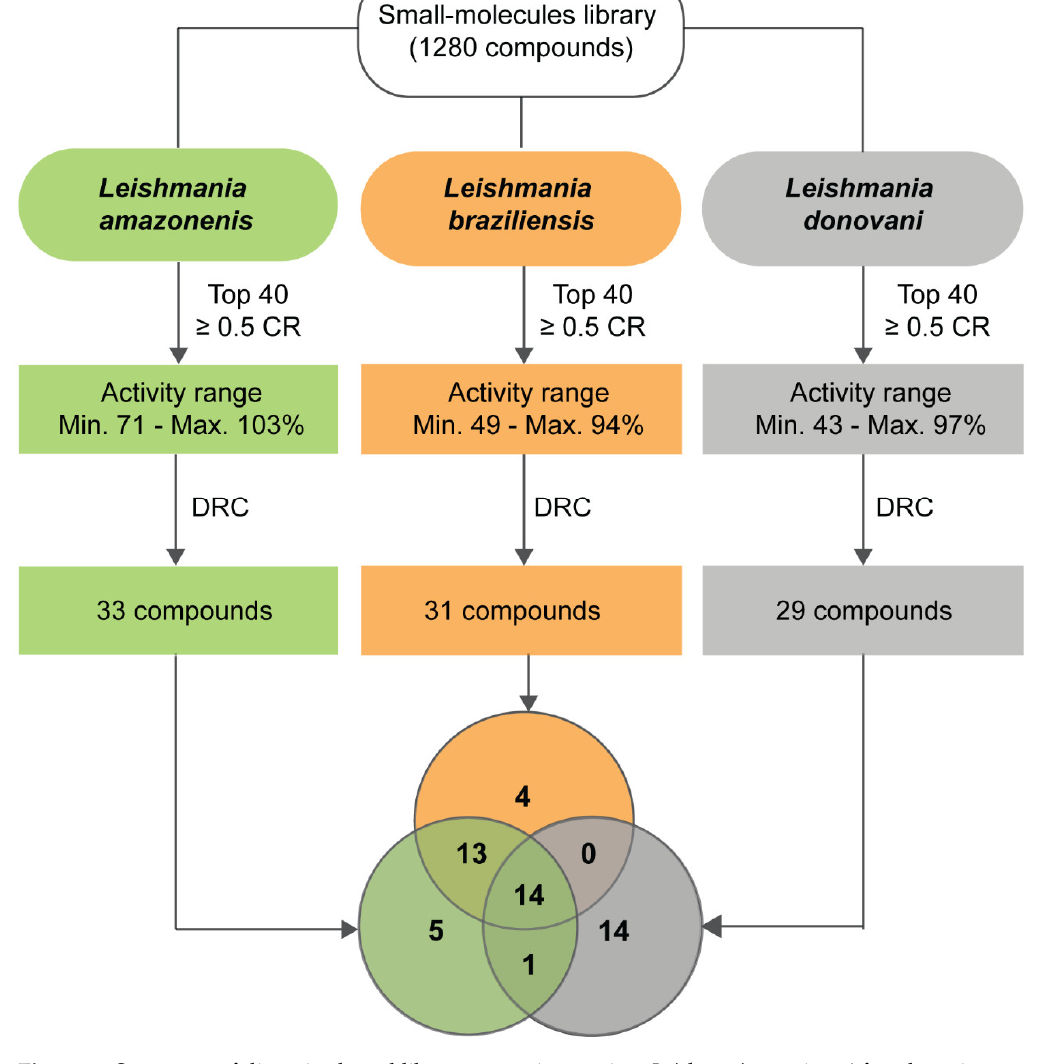
Figure 5. Summary of diversity-based library screening against Leishmania species. After the primary screening, the 40 most active compounds (top 40) with cell ratio (CR) ≥ 0.5 were selected in each model. The activity range of the selected compounds is shown in first squares. The top 40 compounds were then tested in dose–response experiments, and the number of compounds with determined EC 50 is presented in second squares. The 51 compounds selected from all models are exhibited in the Venn Diagram, which shows their activity spectrum.